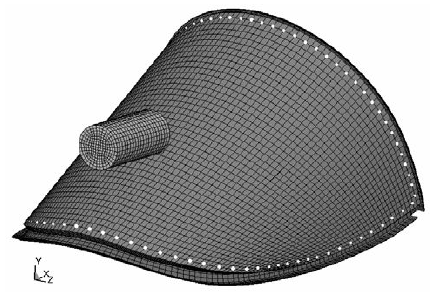
Fig. 8. FE model of windshield structure for bird strike.